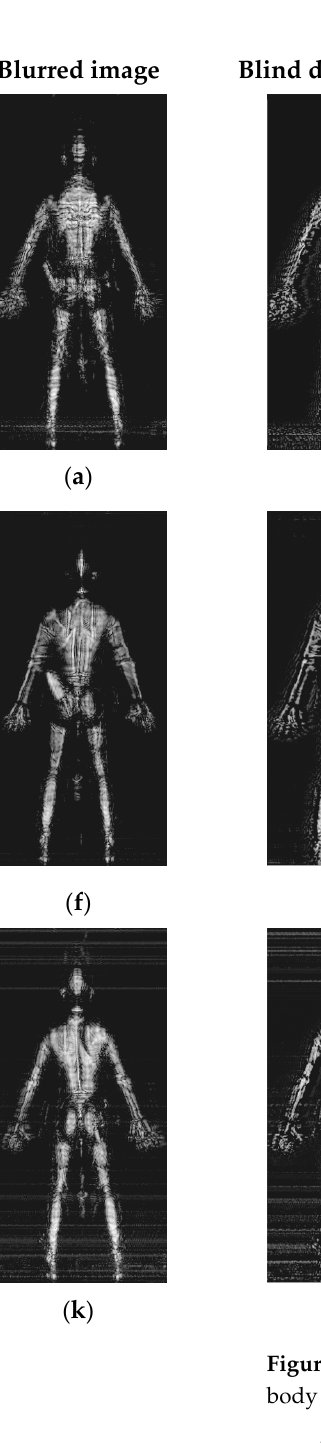
proposed method decreases by 16.83% on